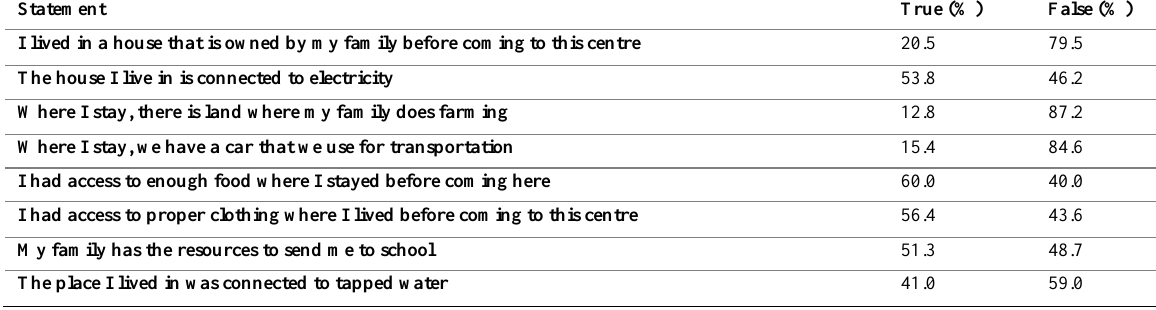
Table 7: Children Socio-economic